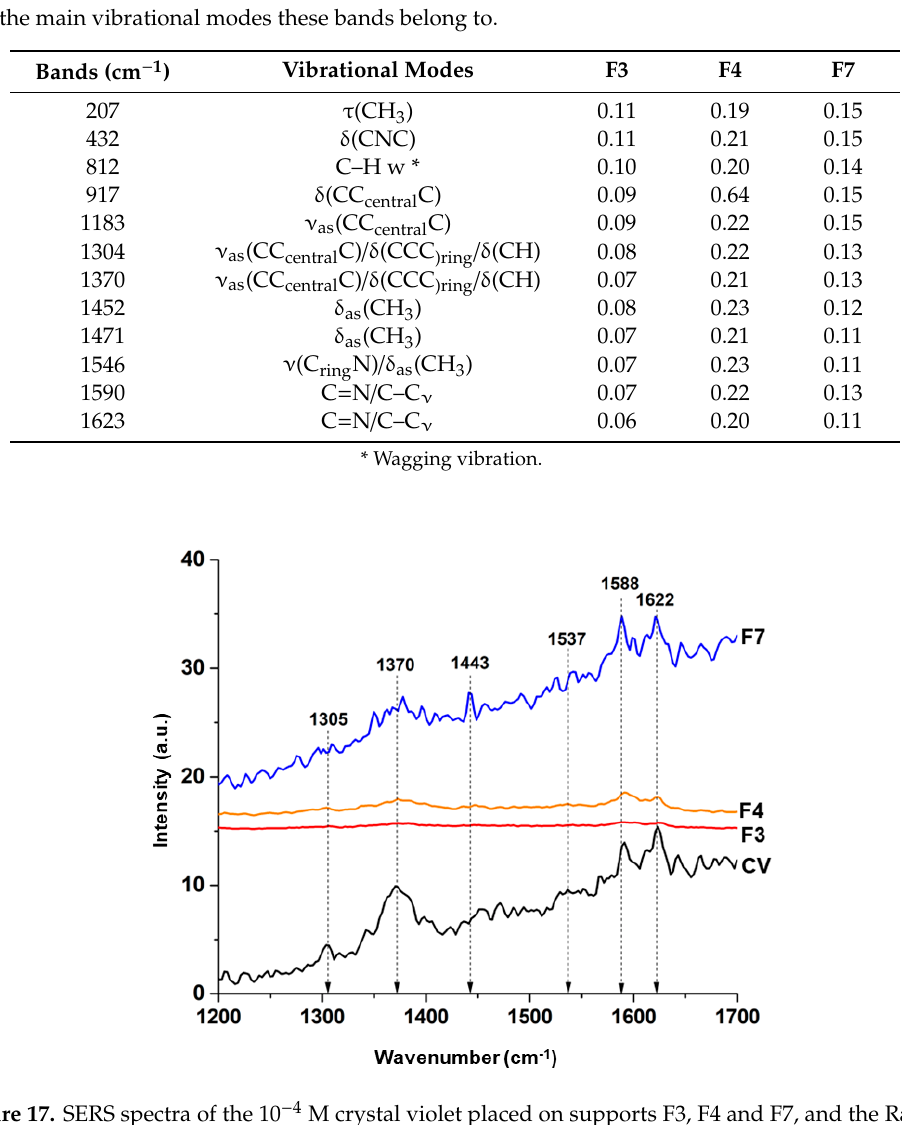
Figure 17. SERS spectra of the 10 − 4 M crystal violet placed on supports F3, F4 and F7, and the Raman spectrum of 10 − 4 M crystal violet (black), confined to a spectral interval between 1200 and 1700 cm − 1 .